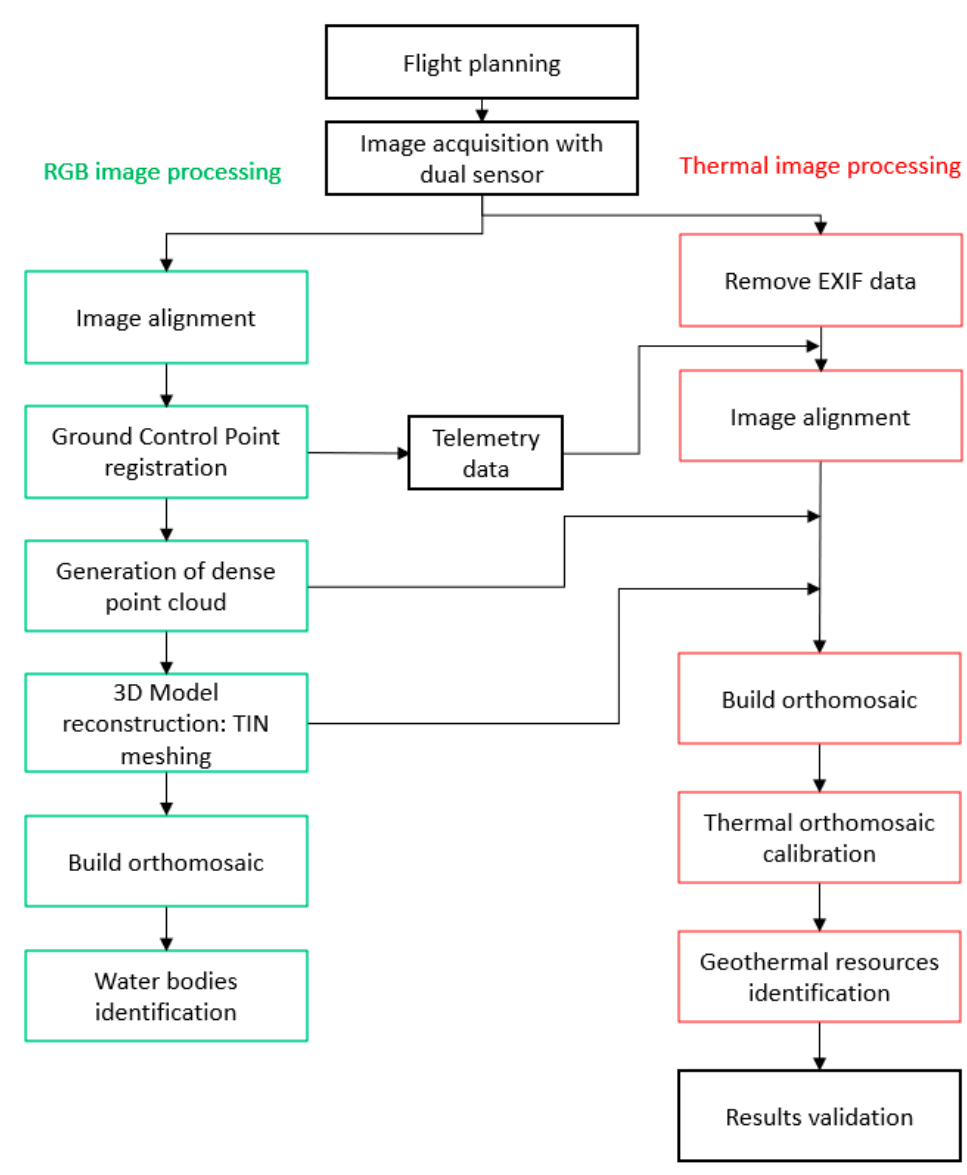
Figure 1. Proposed workflow.